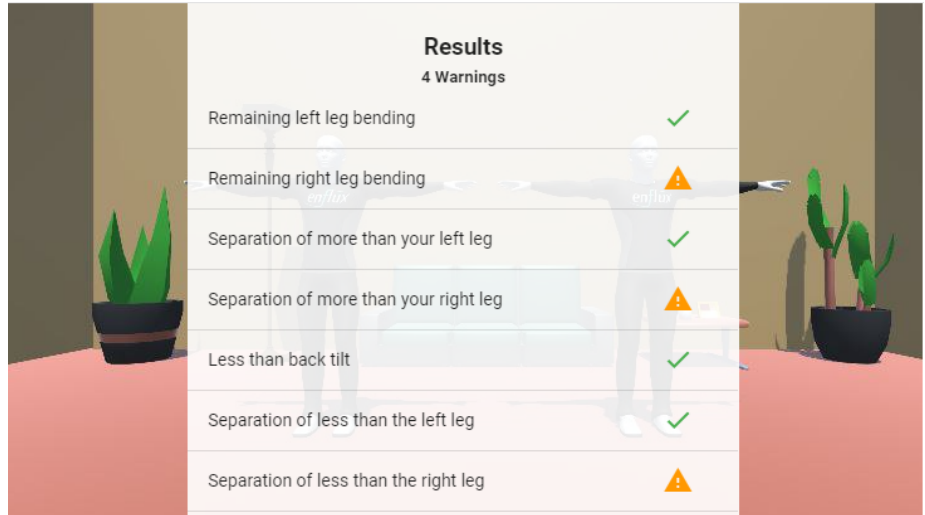
Figure 6. Errors when the user has done the